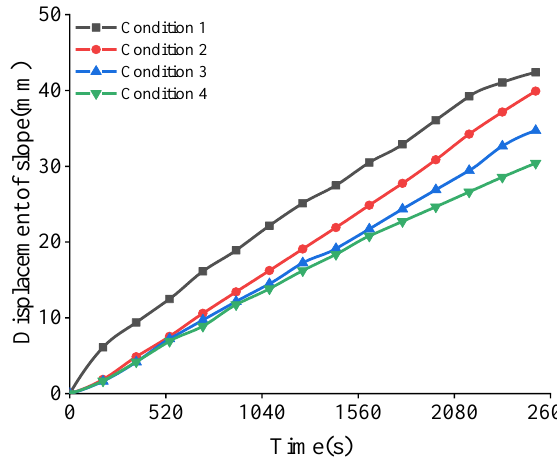
Figure 10. Slope displacement of the four conditions.